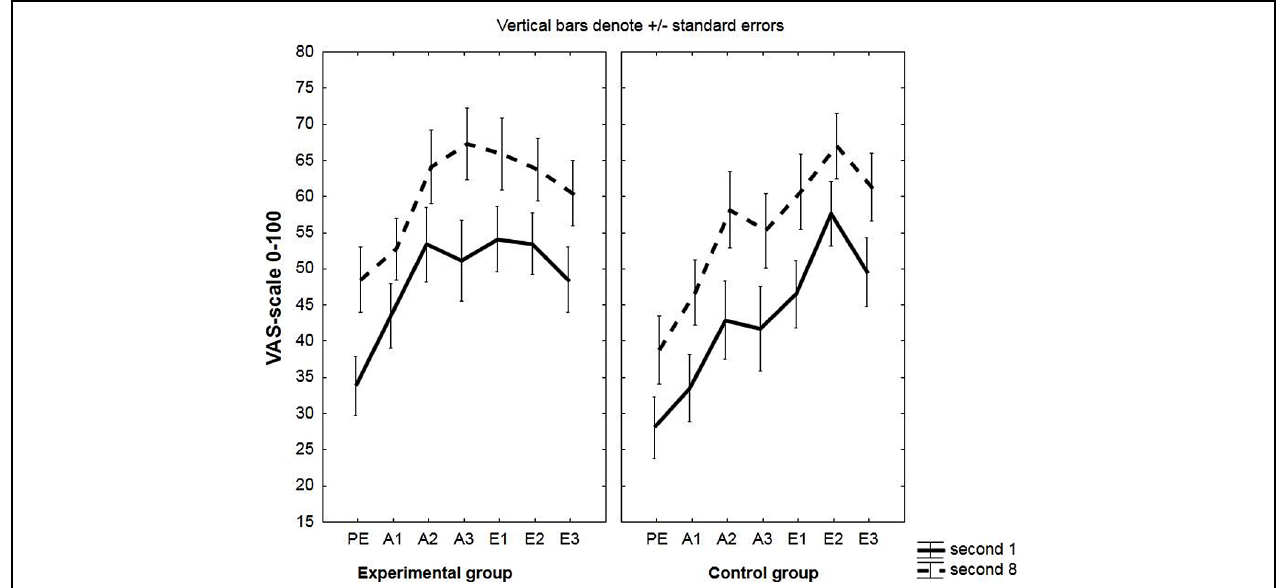
FIGURE 1 | Unconditioned stimulus (US)-expectancy during the conditioned stimulus (CS)-period. Mean US-expectancy ratings of second 1 and second 8 during the conditioned stimuli (CSs) on a VAS-scale ranging from 0 (certainly no breathing resistance) to 100